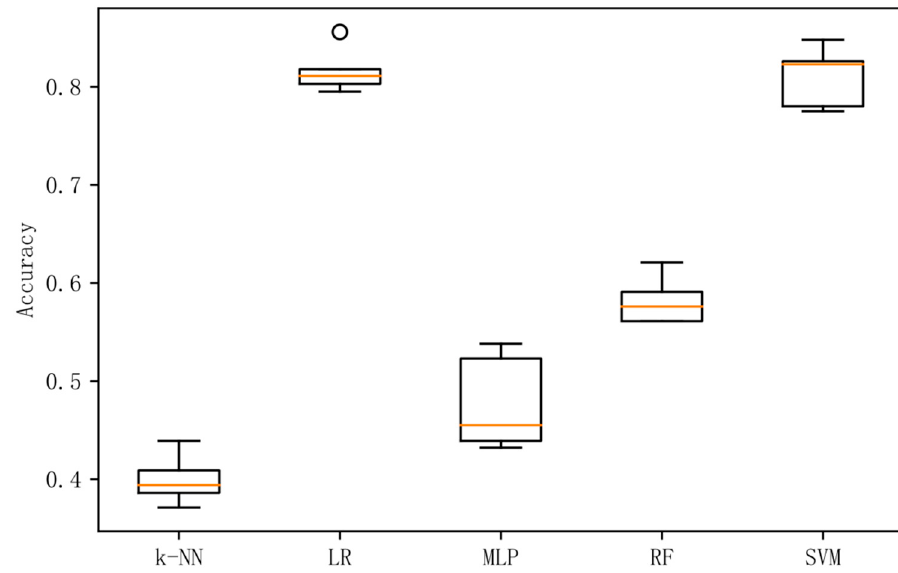
Figure 5. Accuracy in differential entropy dataset based on LDA with five methods.